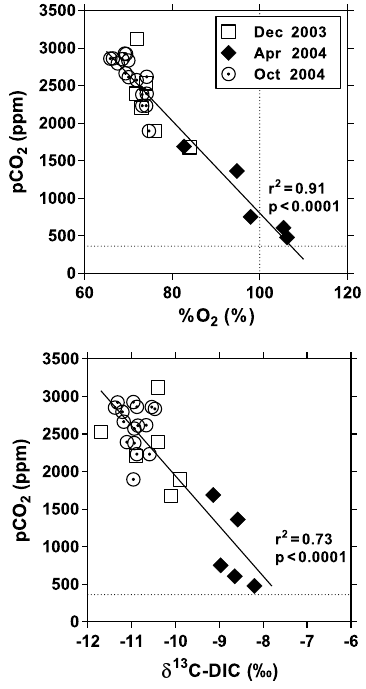
Figure 4. Variation in the partial pressure of CO 2 (pCO 2 , ppm) as a function of oxygen saturation level (%O 2 , %) and stable iso- tope composition of dissolved inorganic carbon ( δ 13 C-DIC, ‰) in the freshwaters (salinity 0) of the three branches of the Mekong delta (M e y Tho, Hàm Luông, and C ´ˆ o Chiên) in December 2003, April 2004, and October 2004. The vertical dotted line indicates O 2 saturation (100%); the horizontal line indicates the average at- mospheric pCO 2